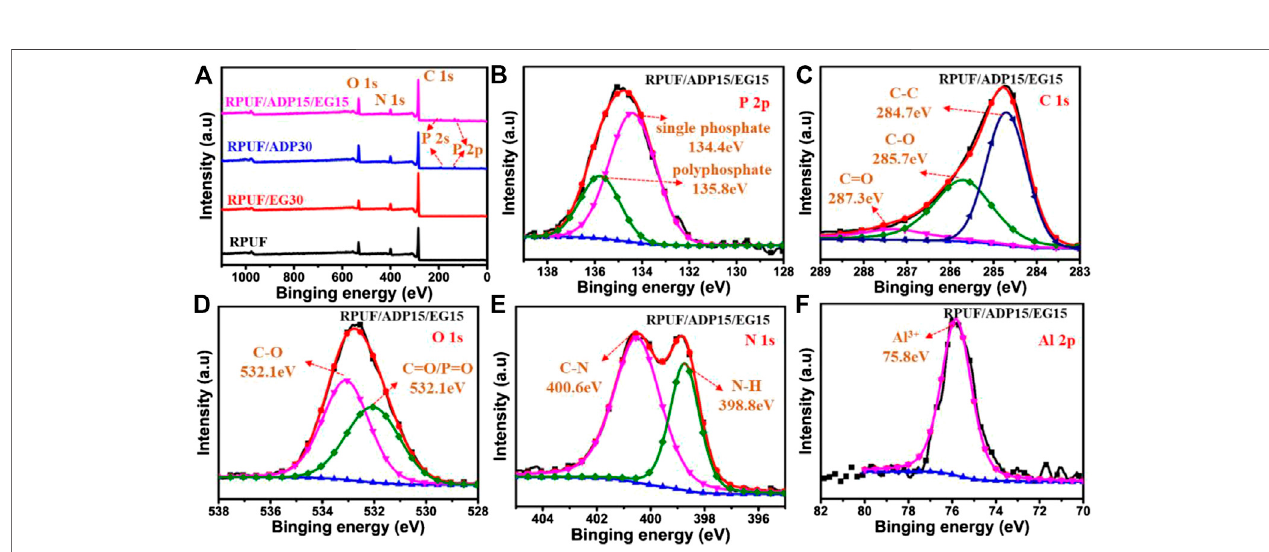
FIGURE7|(A) XPSsurveyspectrumoftheresidualchar forRPUFand itsnanocompositesafter conetests; high-resolution, (B) P2p, (C) C1s, (D) O1s, (E) N1s, and (F) Al 2p XPS spectra of RPUF/ADP15/EG15.